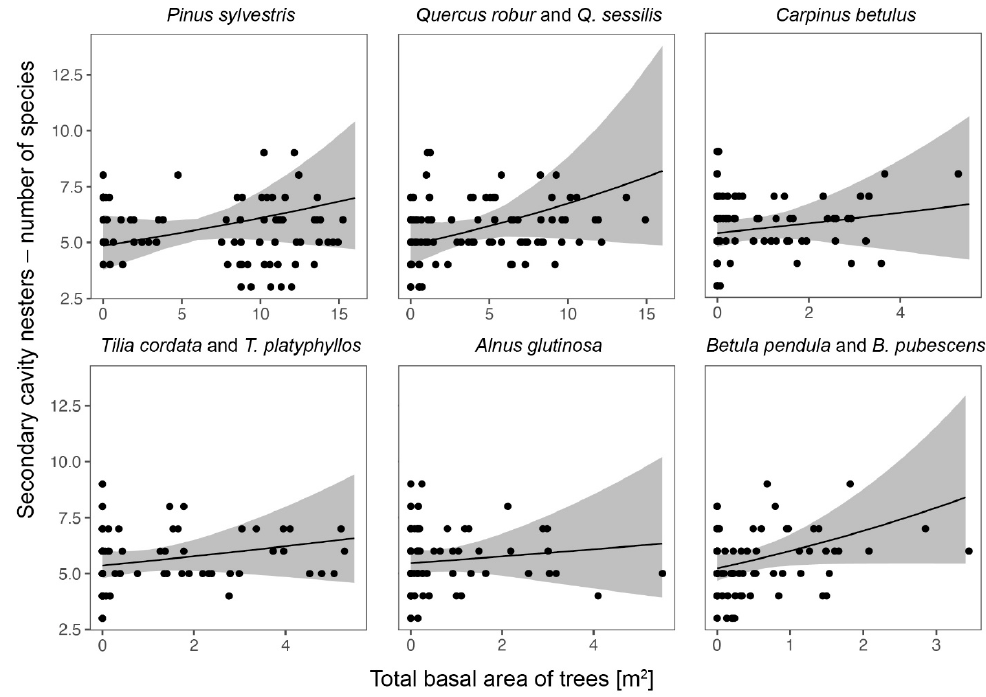
Figure 3. Relationships between species richness of secondary cavity nesters (N/10 ha) and total basal area of trees thicker than 20 cm DBH (m 2 /0.45 ha), estimated using generalized linear models (GLMs) with log link function (Table 6). Dots represent measured values, line—prediction, gray area—95% confidence interval for prediction.